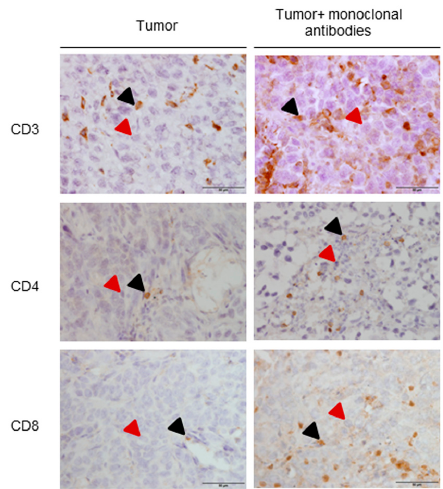
Figure 3. Representative examples of immunohistochemistry staining for CD3, CD4, and CD8, in tumor samples of the di ff erent study groups of mice. All types of T cells (CD3, CD8, and CD4) are stained in brown color (black arrows), while negative nuclei are stained in purple color (red arrows).